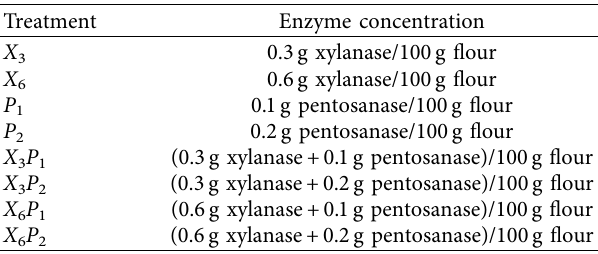
Table 1: Composition of the enzymatic treatments of a baguette bread formulated with different levels of xylanase and pentosanase